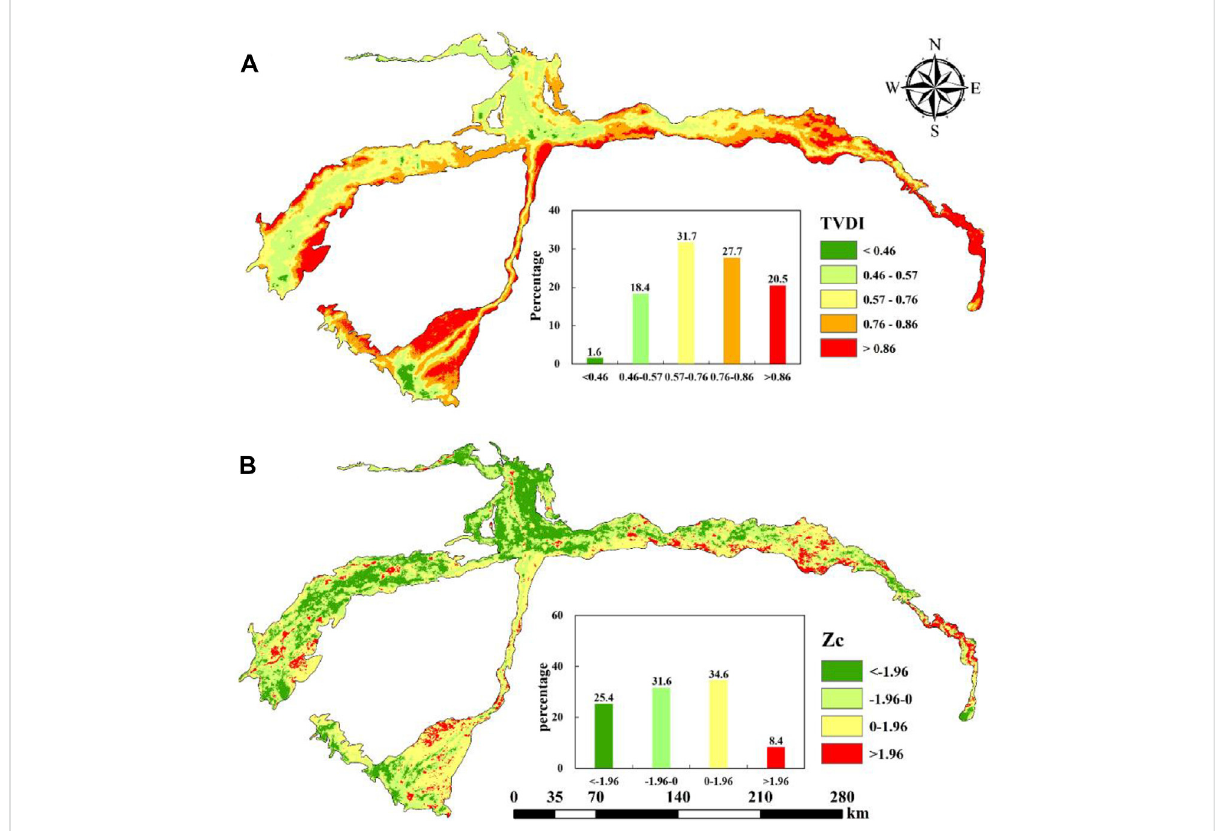
FIGURE 2 Spatial distribution (A) of annual average TVDI and spatial distribution (B) of TVDI variation trend in Tarim River Basin from 2000 to